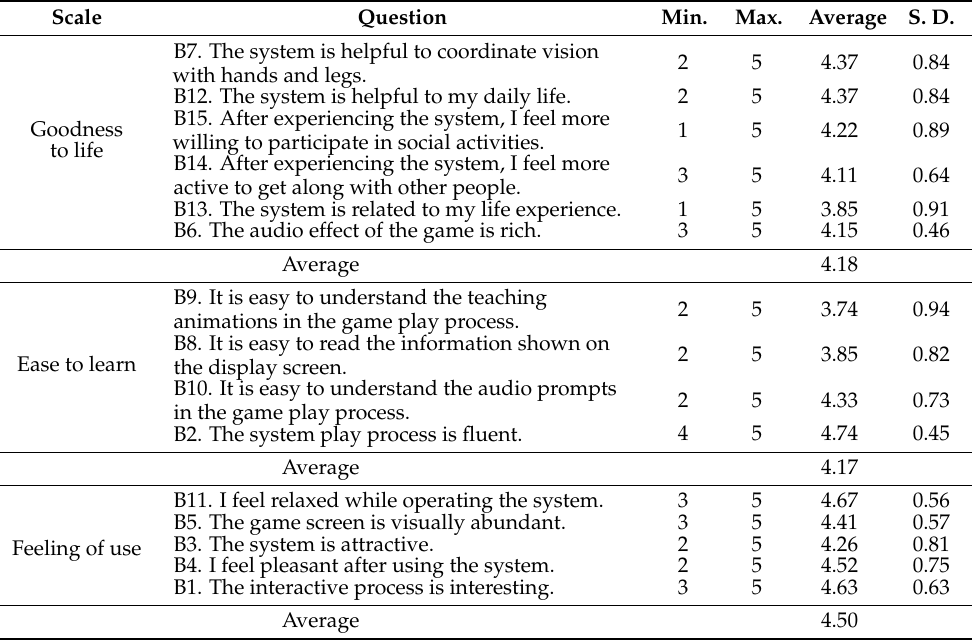
Table A7. Statistics of the average Likert scores of the users’ answers of the questionnaire survey for the aspect of user interaction satisfaction (S.D.: standard